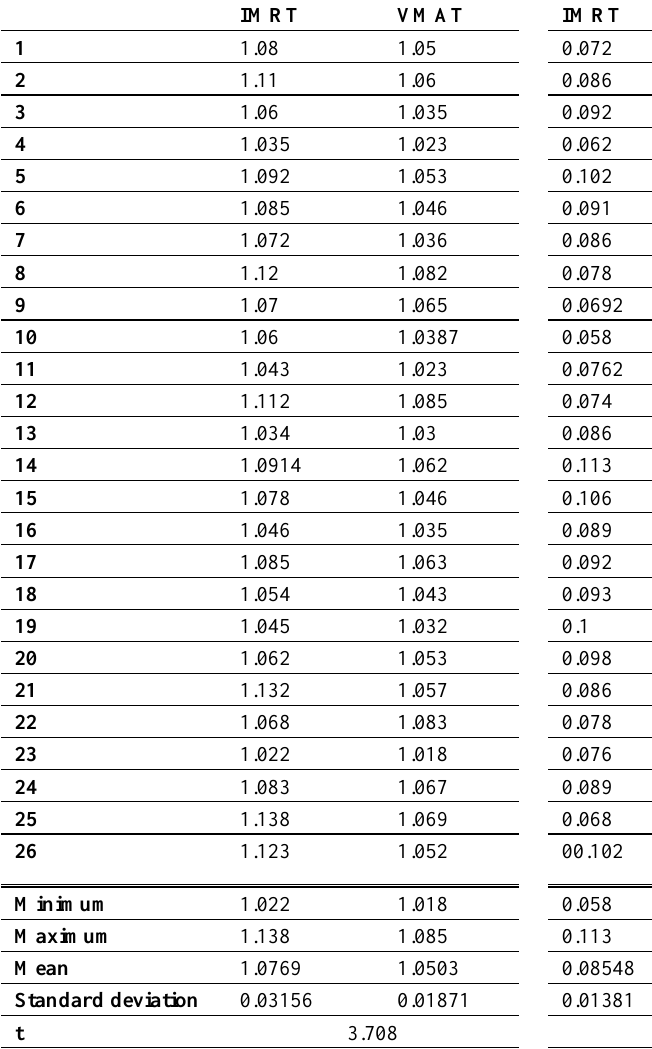
Table 1: Comparison between volumetric-modulated arc therapy (VMAT) and intensity-modulated radiotherapy (IMRT) as regards conformity index (CI), homogeneity index (HI) and pelvic bone marrow (PBM) dose Patient’s No. CI